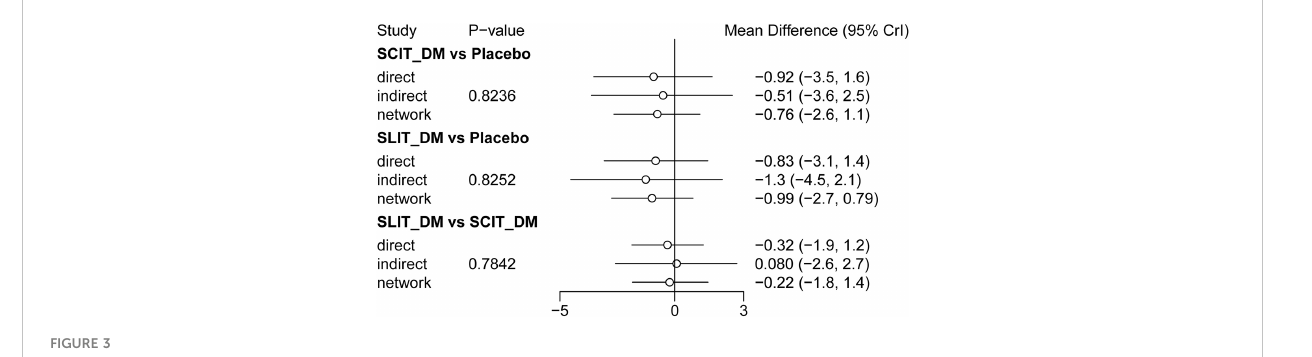
FIGURE 3 Forest